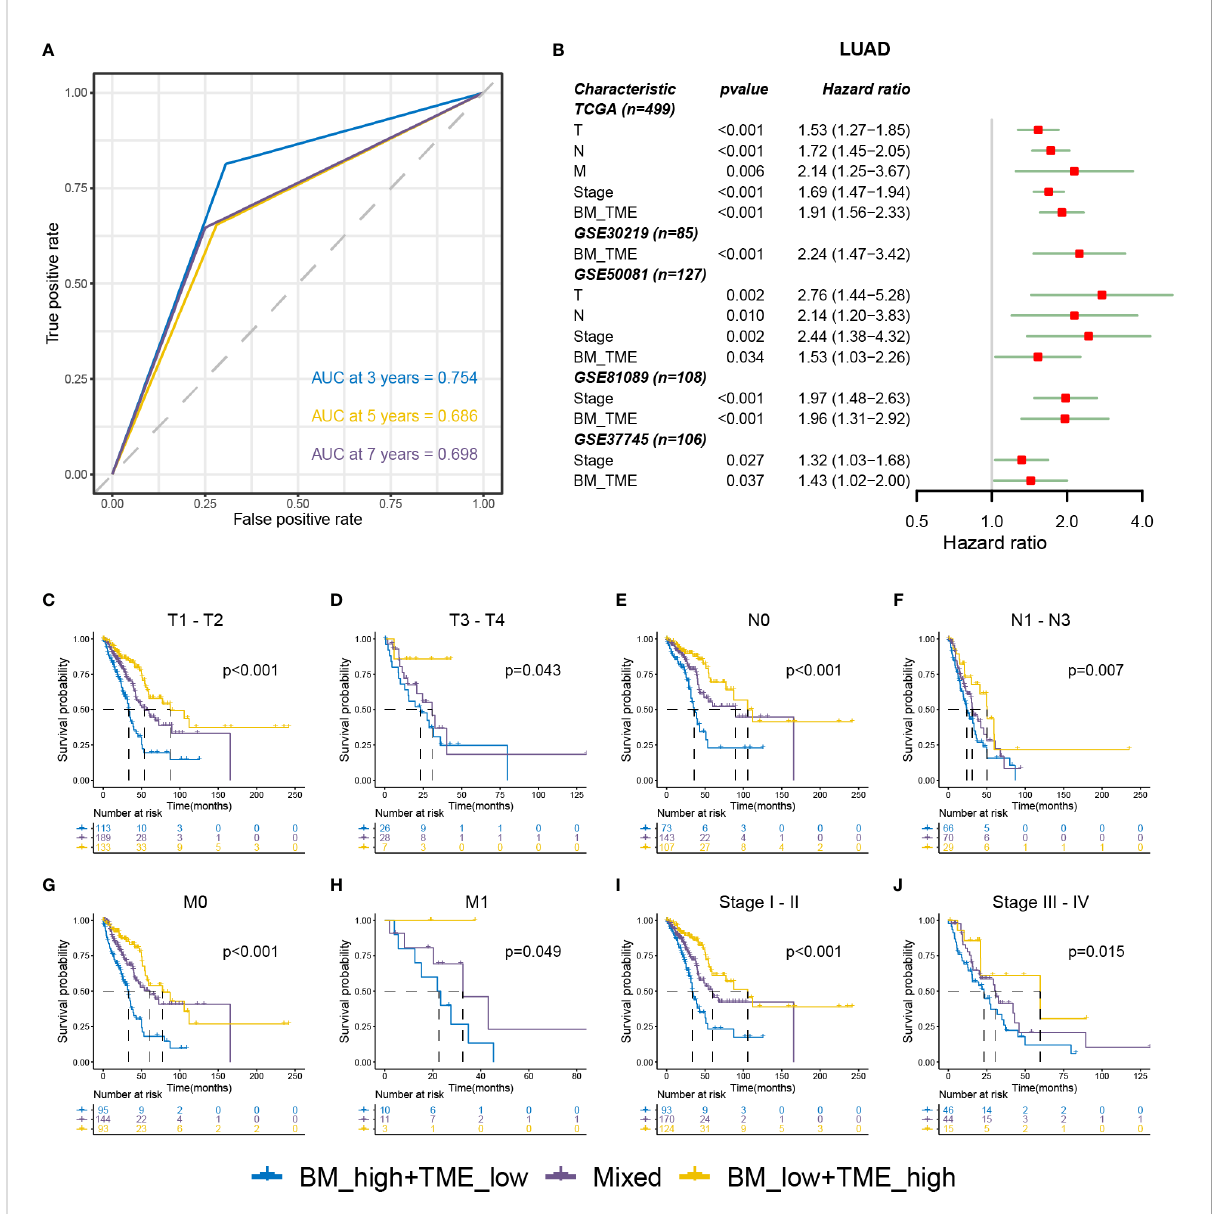
FIGURE 5 Relationships between BM-TME classi fi er and clinical features in LUAD. (A) ROC curves for the 3-, 5- and 7-year overall survival based on the BM-TME classi fi er in TCGA-LUAD cohort. (B) Univariate Cox analysis of clinical characteristics and BM-TME classi fi er in fi ve LUAD cohorts. (C – J) Kaplan – Meier overall survival curves of BM-TME classi fi er in diverse LUAD clinical subtypes in TCGA-LUAD